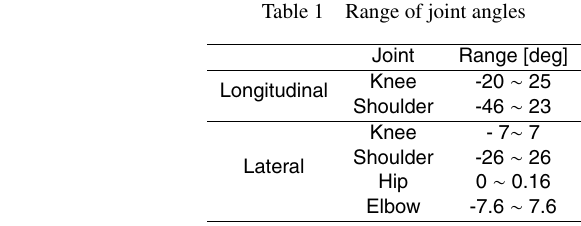
Table 1 Range of joint